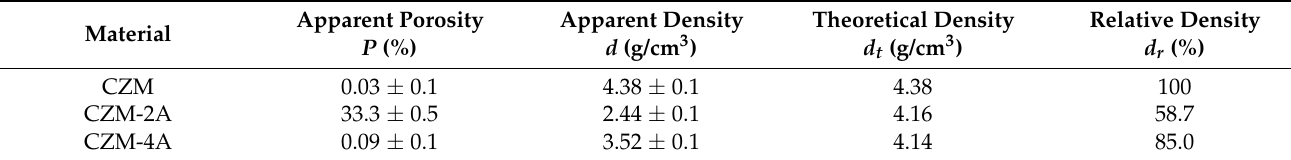
Table 2. Apparent porosity and densities of the three materials.